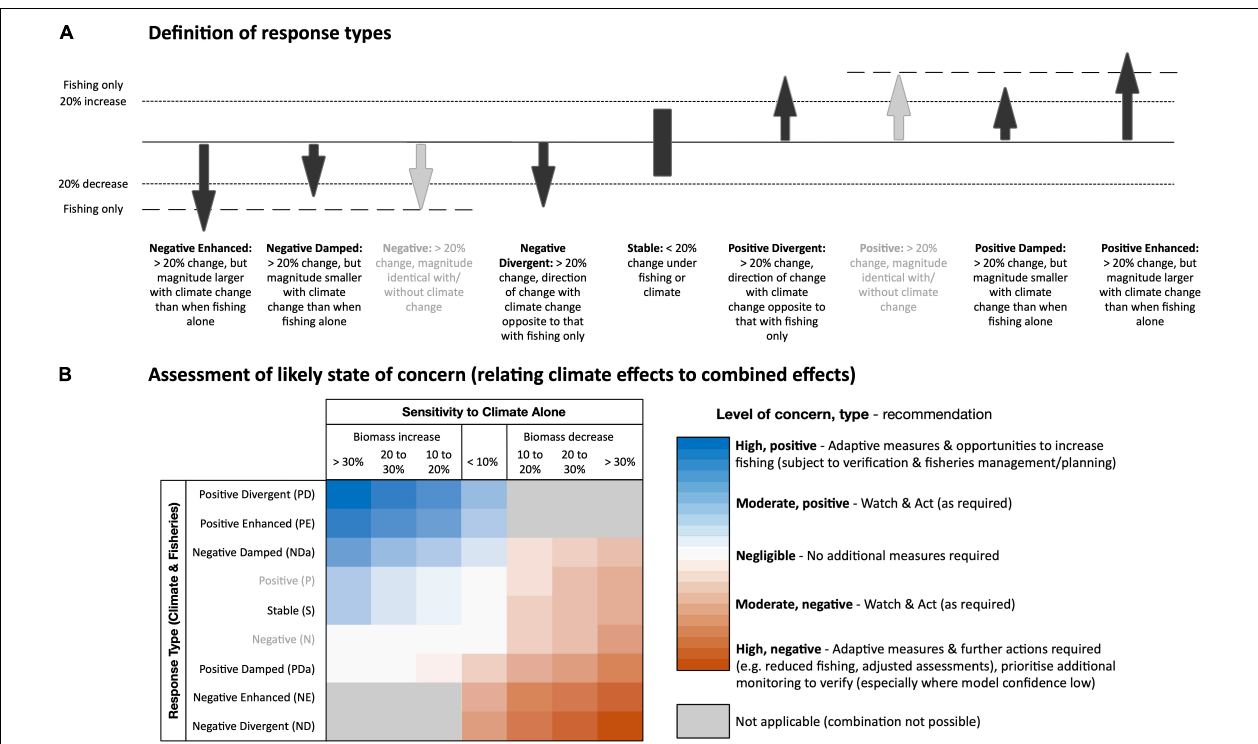
FIGURE 2 | (A) Definitions of different responses types based on differences between biomass trends under the fisheries impacts only (control scenario) and the combined impacts of climate change and fisheries (RCP8.5 scenario) between 2045 and 2050. Response types in gray were classified as stable responses as they too represent a < 20% difference in biomass. (B) Assessment of the level and type of likely state of concern for functional groups were based on classification of (1) sensitivity or scale and direction of relative biomass changes to the climate change only scenario, and (2) the response type. Dampened response may appear to sit out of order, but this is because of their response to climate alone is in the opposite direction to their combined response.